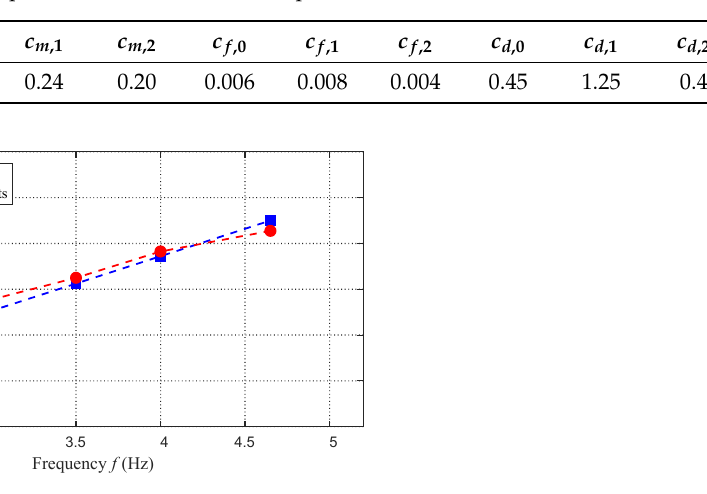
Figure 9. Comparisons between simulated results and experimental